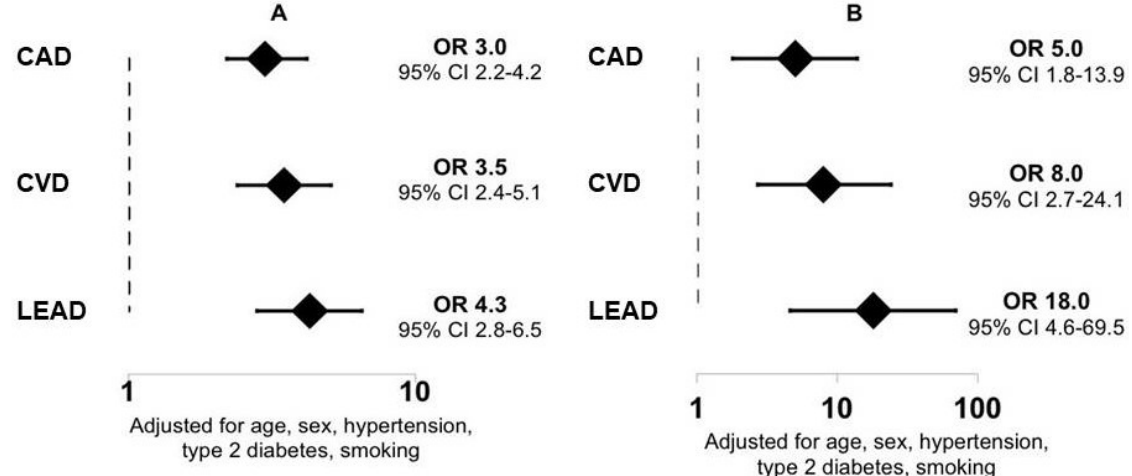
Figure 3. Odds ratios of cardiovascular diseases ( A ) in the case of hyperlipoproteinemia(a), and ( B ) in the case of hyper- lipoproteinemia(a) and the level of IgM autoantibodies against lipoprotein(a) being below the median. Data are presented as odds ratio (ORs) and 95% confidence intervals. CAD: coronary artery disease, CVD: cerebrovascular disease, LEAD: lower extremity artery disease.